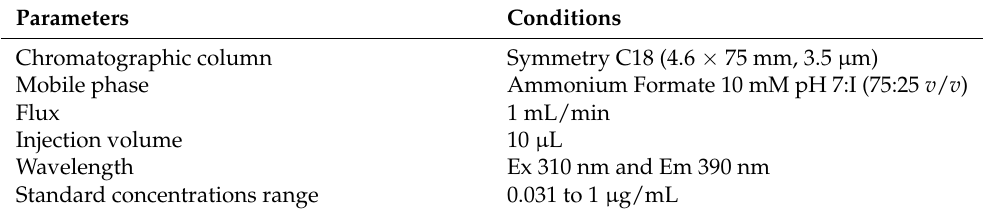
Table 3. Chromatographic conditions for the determination of